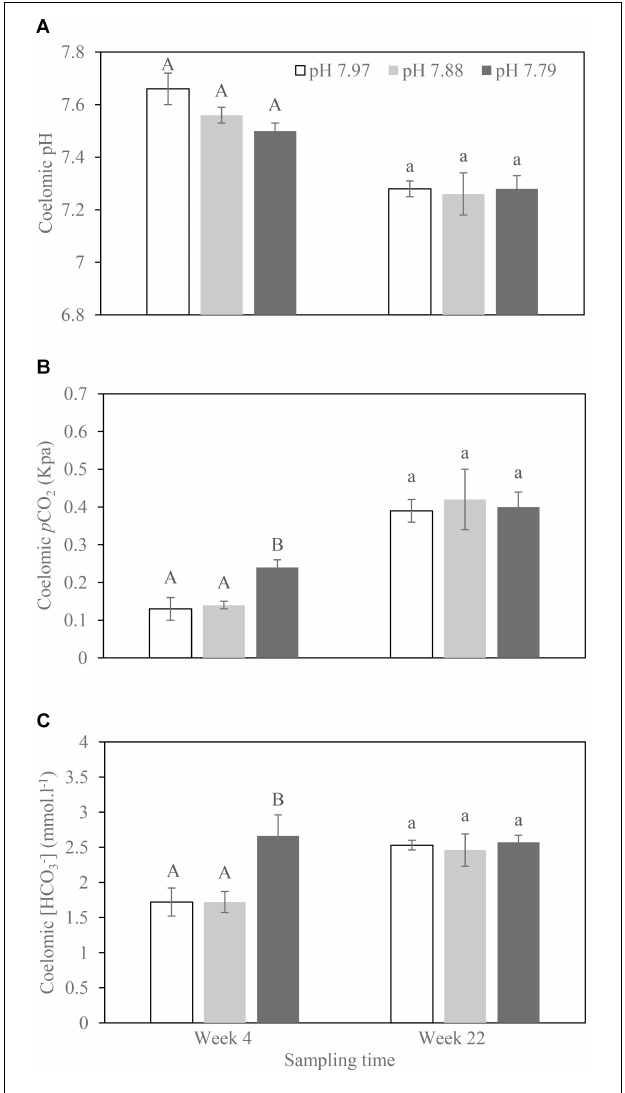
FIGURE 1 | Acid–base balances ( (A) Coelomic pH; (B) Coelomic pCO2; (C) Coelomic [HCO − 3 ]) of the sea cucumber H. forskali coelomic fluid sampled at weeks 4 and 22, respectively, when exposed to pH 7.97, 7.88, and 7.79 levels. Data (expressed as mean ± SEM, n = 6) with different letters in the same time point identifying statistically significant differences (Tukey HSD, p < 0.05).